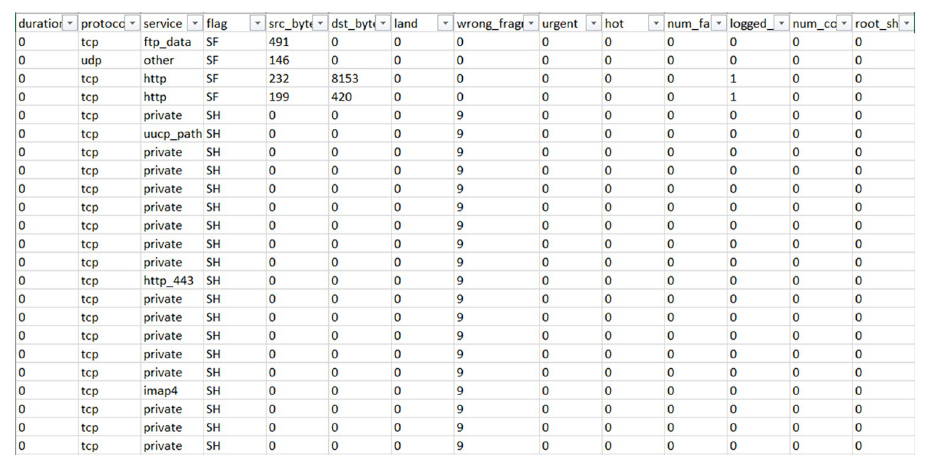
Fig 1. Trained dataset after preprocessing.